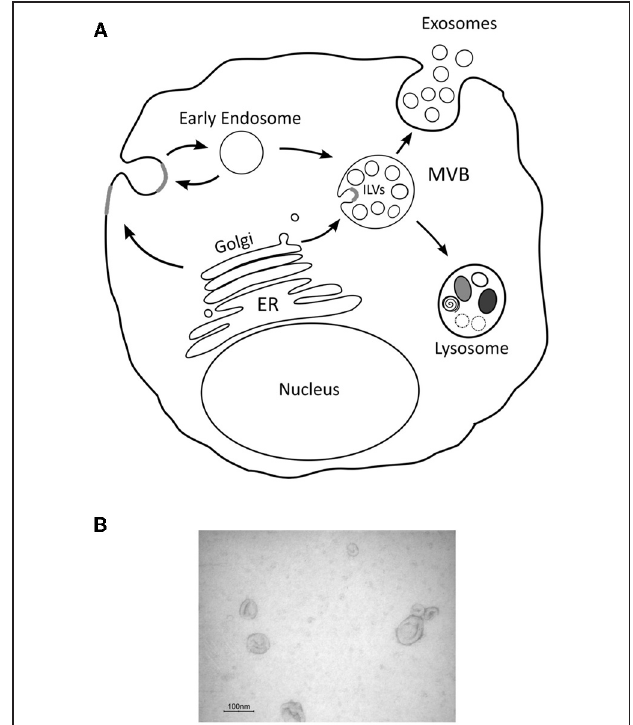
FIGURE 2 | Schematic representation of exosome biogenesis. Intraluminal vesicles (ILVs) are generated by the inward budding of the limiting membrane of a subgroup of late endosomes called multivesicular bodies (MVBs). MVBs can be directed towards the cell periphery and, after fusion with the plasma membrane, release their content in the extracellular space. Secreted ILVs, now called “exosomes,” are then taken up by target cells (A) . Electron microscopy picture of exosomes isolated by differential ultracentrifugation (B)